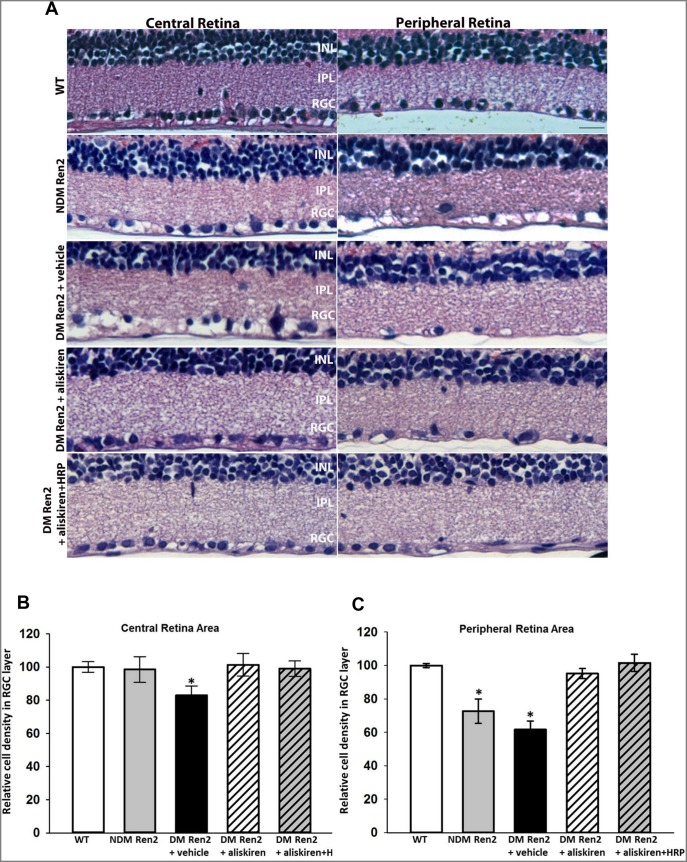
Representative retinal micrographs of wildtype (WT) Sprague–Dawley rats, non-diabetic (NDM) Ren2 rats, and diabetic (DM) Ren2 rats treated with vehicle, aliskiren or aliskiren+HRP (A).INL: inner nuclear layer; IPL: inner plexiform layer; RGC: retinal ganglion cell layer. Quantitative measurement of cell density in RGC layer in the central (B) and peripheral (C) retinas of wildtype (WT) Sprague–Dawley rats, non-diabetic (NDM) Ren2 rats, and diabetic (DM) Ren2 rats treated with vehicle, aliskiren or aliskiren+HRP. N = 4. *p<0.01 (vs. WT).